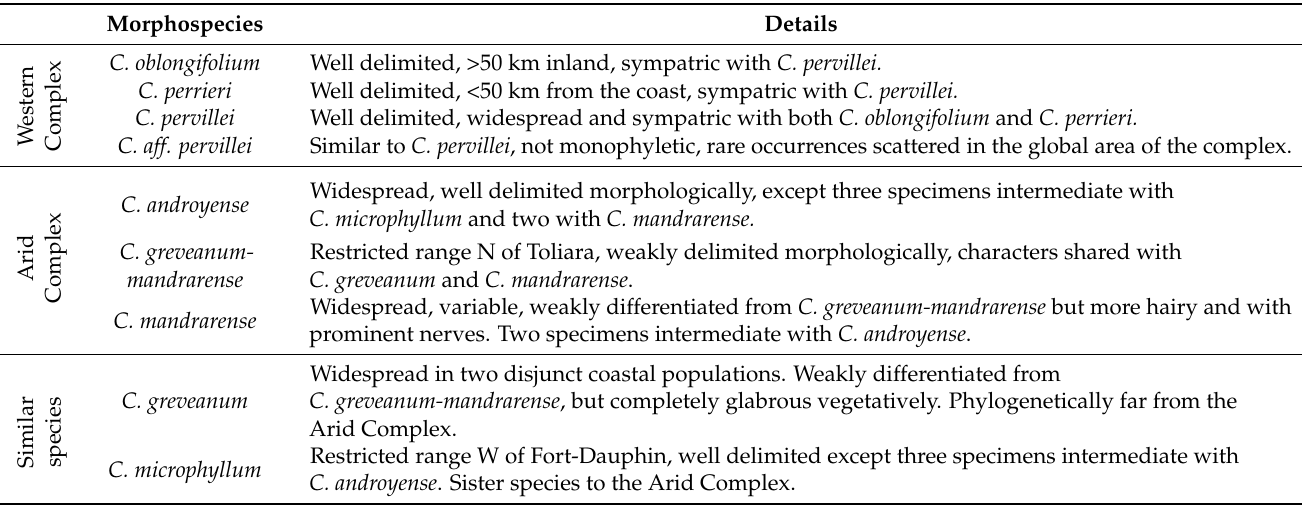
Table 1. Morphospecies included in each species complex with information related to their delimitation, distribution and phylogenetic